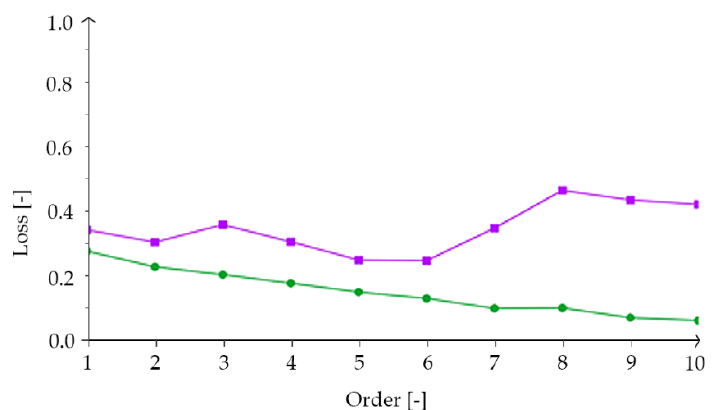
Figure 4. The loss history from incremental order algorithm execution, within 10 iterations, where the green line is the training loss and the purple line is the selection loss. Loss is on the vertical axis and order is on the horizontal axis.